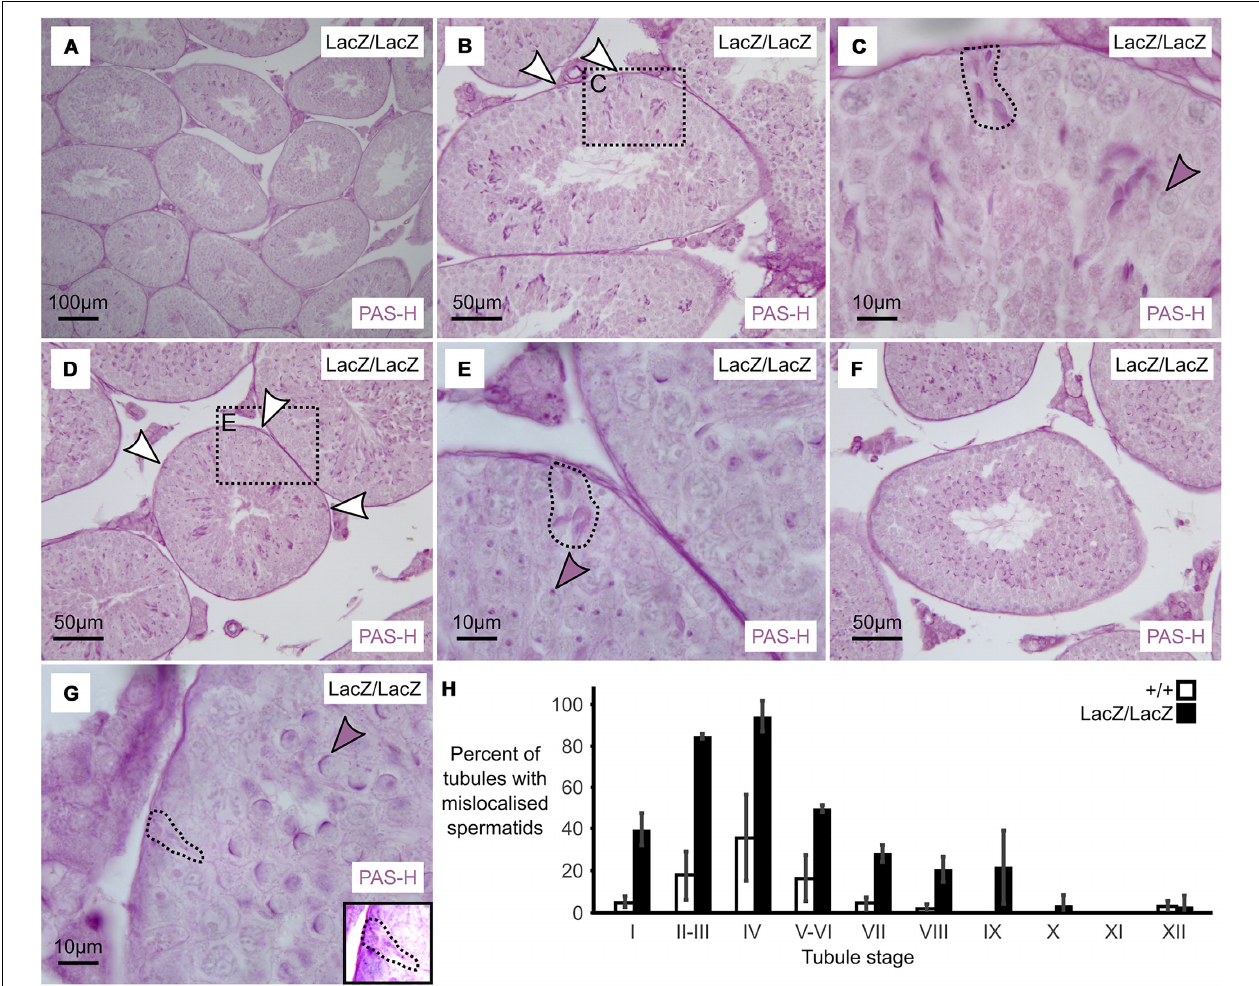
FIGURE 3 | Massive loss of maturing sperm in Fbxo7 mutant males. (A–G) PAS-H staining of Fbxo7LacZ/LacZ testis sections used to quantitate spermatid mis-localisation. PAS marks the developing acrosome in purple, allowing both identification of the mis-localised elongating spermatids and also tubule staging. Panel (A) shows a low magnification view indicating general testis architecture. Panel (B,D,F) show complete tubules at stage II, IV, and VI, respectively, and white arrowheads indicate mislocalised elongating spermatids apposed to the basement membrane of the tubules – these are rarely visible at stage VI. Panel (C,E,G) show high magnification images at tubule stages II, IV and VI. Dotted outlines highlight mislocalised elongating spermatids, while shaded arrowheads indicate the developing acrosomes in the round spermatid layer, used to stage the tubules. Mislocalised spermatids were readily detected up to stage IV. After stage IV, the mislocalised cells were still present but began to lose their PAS staining were thus harder to detect. Panel (G) inset shows a rare example of a mislocalised cell remaining visible by PAS staining at stage VI. (H) Proportion of tubules containing at least one mis-localised cell at each tubule stage in wild type and Fbxo7LacZ/LacZ testes. Error bars indicate standard deviation across replicates ( n = 3 animals per